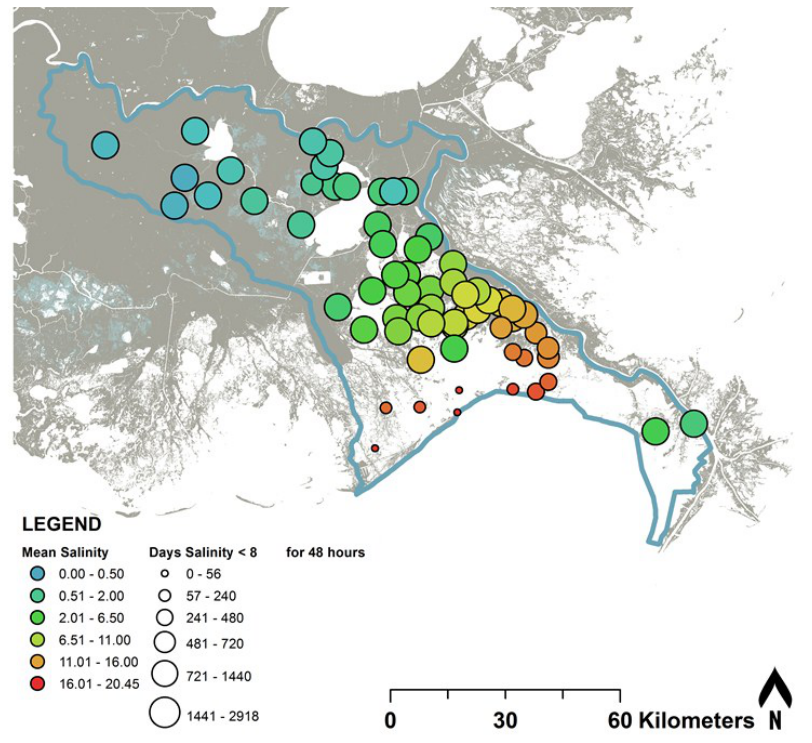
Figure 5. Average salinity by color gradient with the size of the points representing the number of events since 2008 where the salinity was less than 8 ng/kg for at least 48 consecutive hours. Water 2018 , 10 , x FOR PEER REVIEW